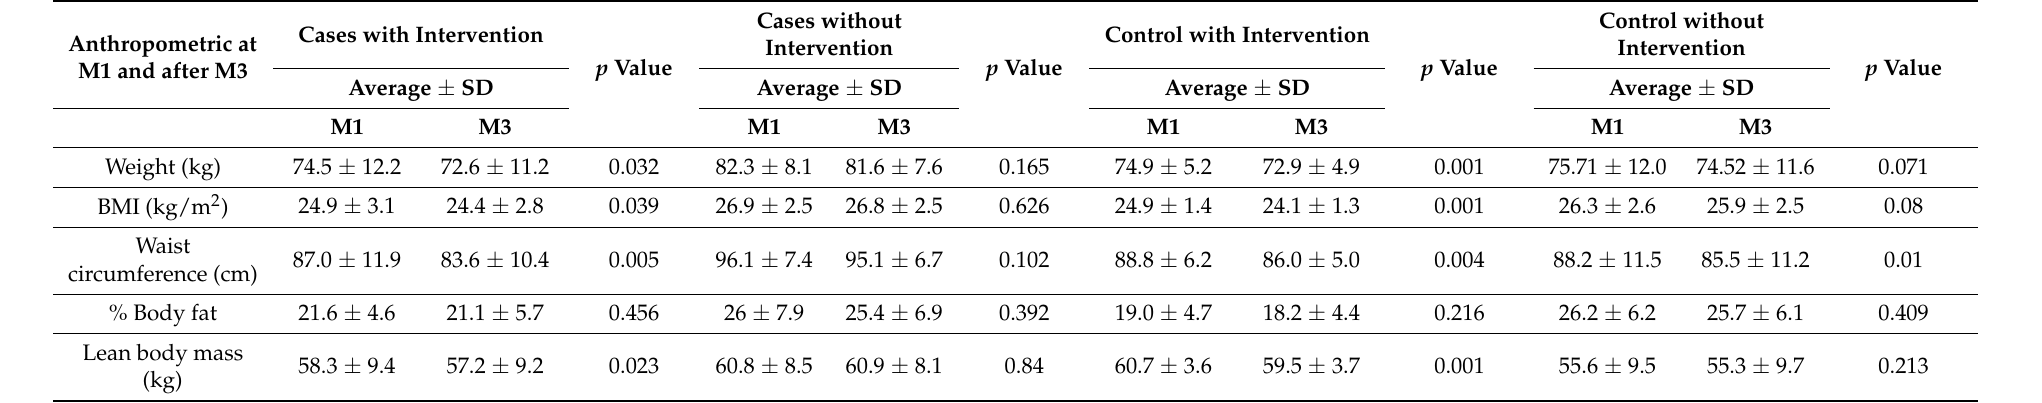
Table 3. Anthropometric at study initiation (M1) and after two months (M3).